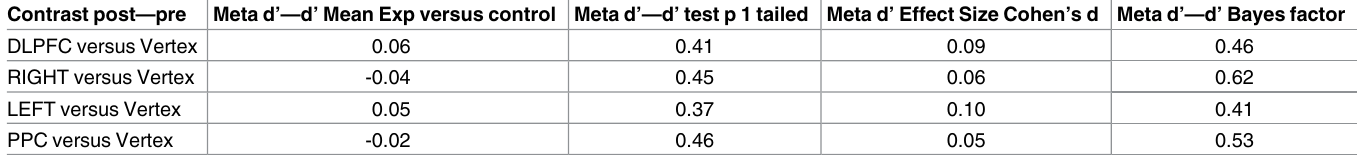
Table 2. Meta d’ table of t tests, effect sizes and Bayesfactors analysesbetween conditions and control (NB for the Rounis study, post—pre TMS meta d’—d’ Mean DLPFC versus sham control was -0.4). Contrast post—pre